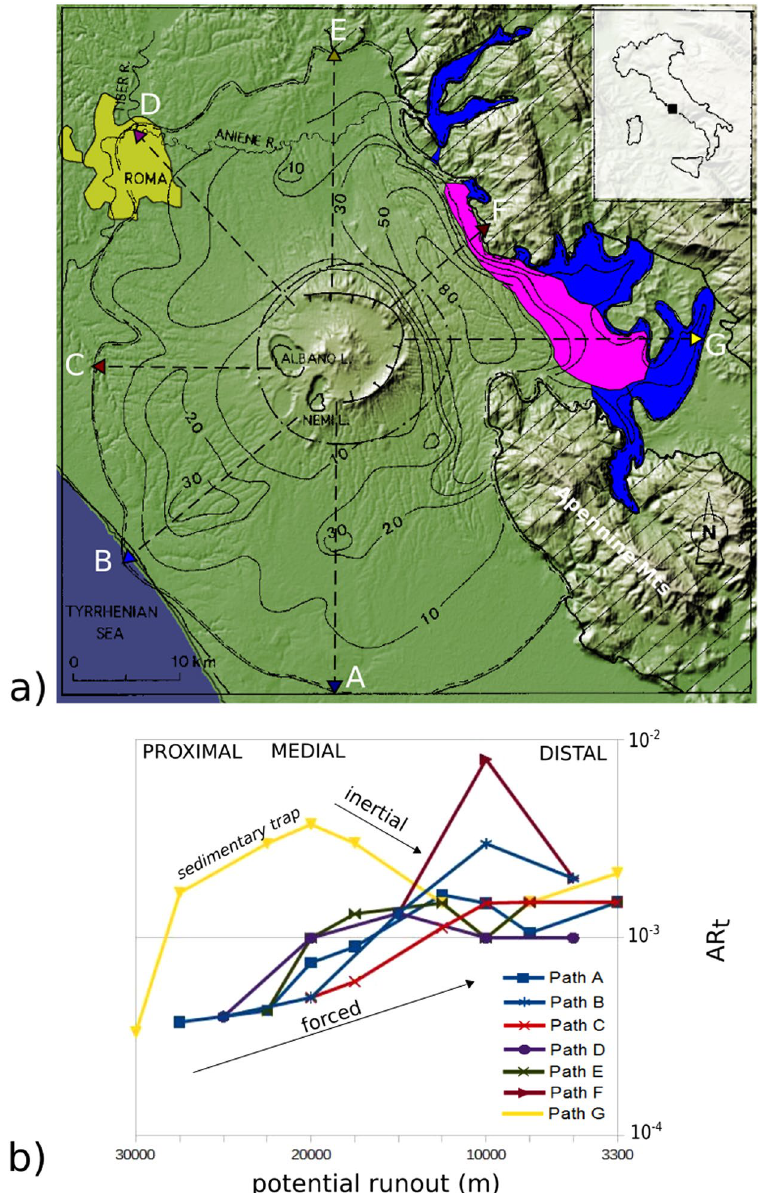
Figure 1. Topological aspect ratio (AR t ) of the Pozzolane Rosse ignimbrite (Colli Albani, Italy; see Table S1 in Suppl. Material for characteristics); ( a ) Isopach map (in m); arrows indicate paths along which AR t has been calculated (see Fig. S2 and Table S2 in Supplementary Material); pink indicates areas where undulations and cross stratifications occur; blue indicates areas where the ignimbrite is valley-confined; the extent of Roma city is pale green. (Modified from 24 ; NASA image created by Jesse Allen, using SRTM data provided courtesy of the University of Maryland’s Global Land Cover Facility, available at http://visibleearth.nasa.gov/view. php?id = 37794). – ( b ) Plot of potential runout versus topological aspect ratio AR t . The slow rise of AR t with distance indicates forced flow conditions as material is mostly transported; inertial conditons are described by a decreasing AR t , e.g. downcurrent respect to sedimentary traps (see text for explanation). (drawing realized with Inkskape ver 0.91